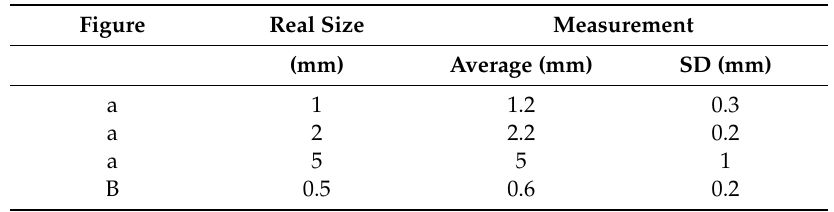
Table 2. Data resulting from Figure 8.